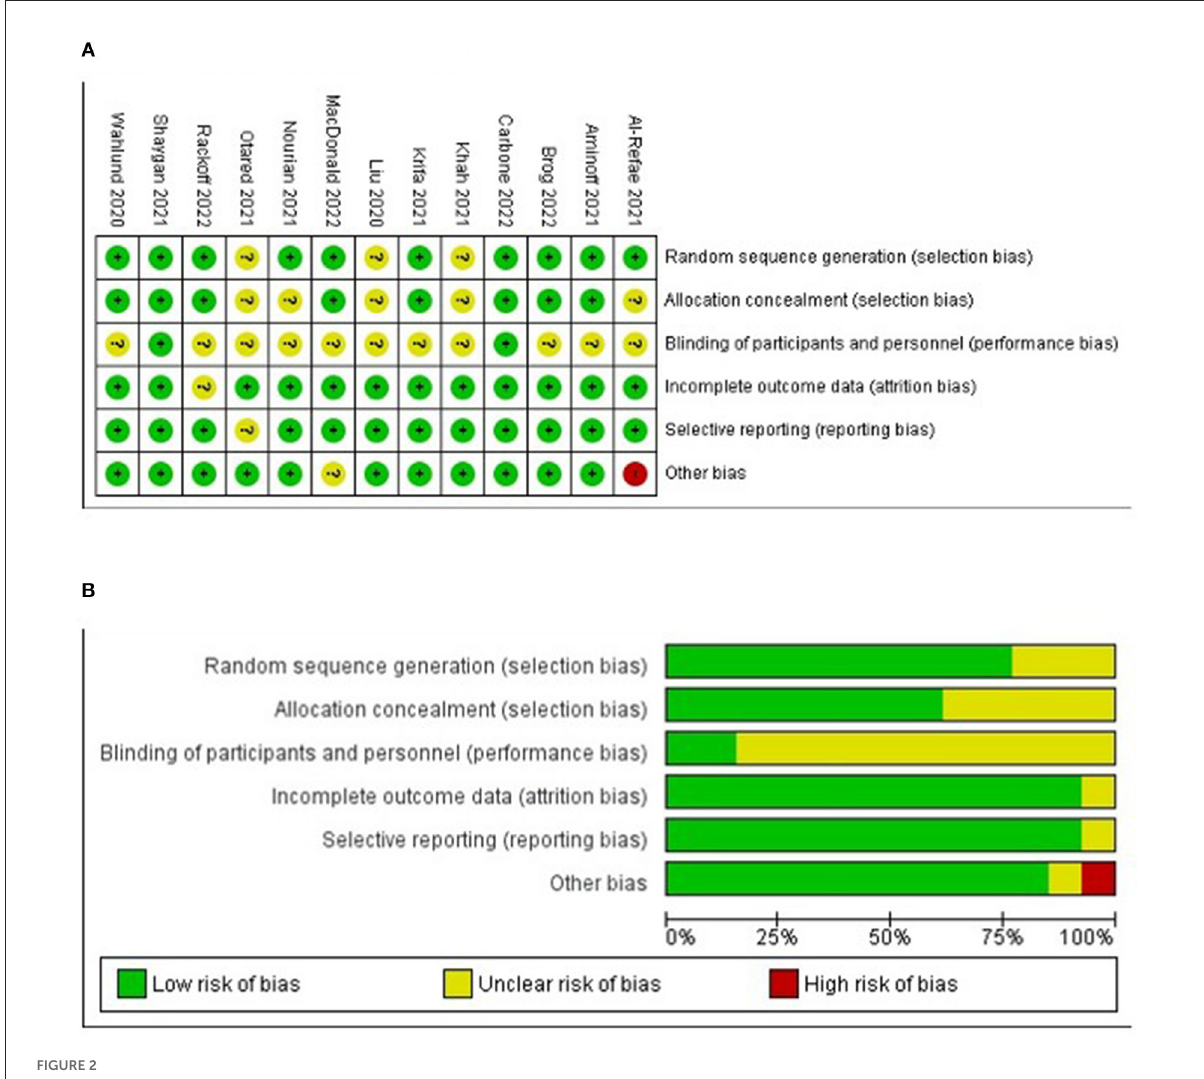
FIGURE2 (A) Risk of bias summary. (B) Risk of bias graph.